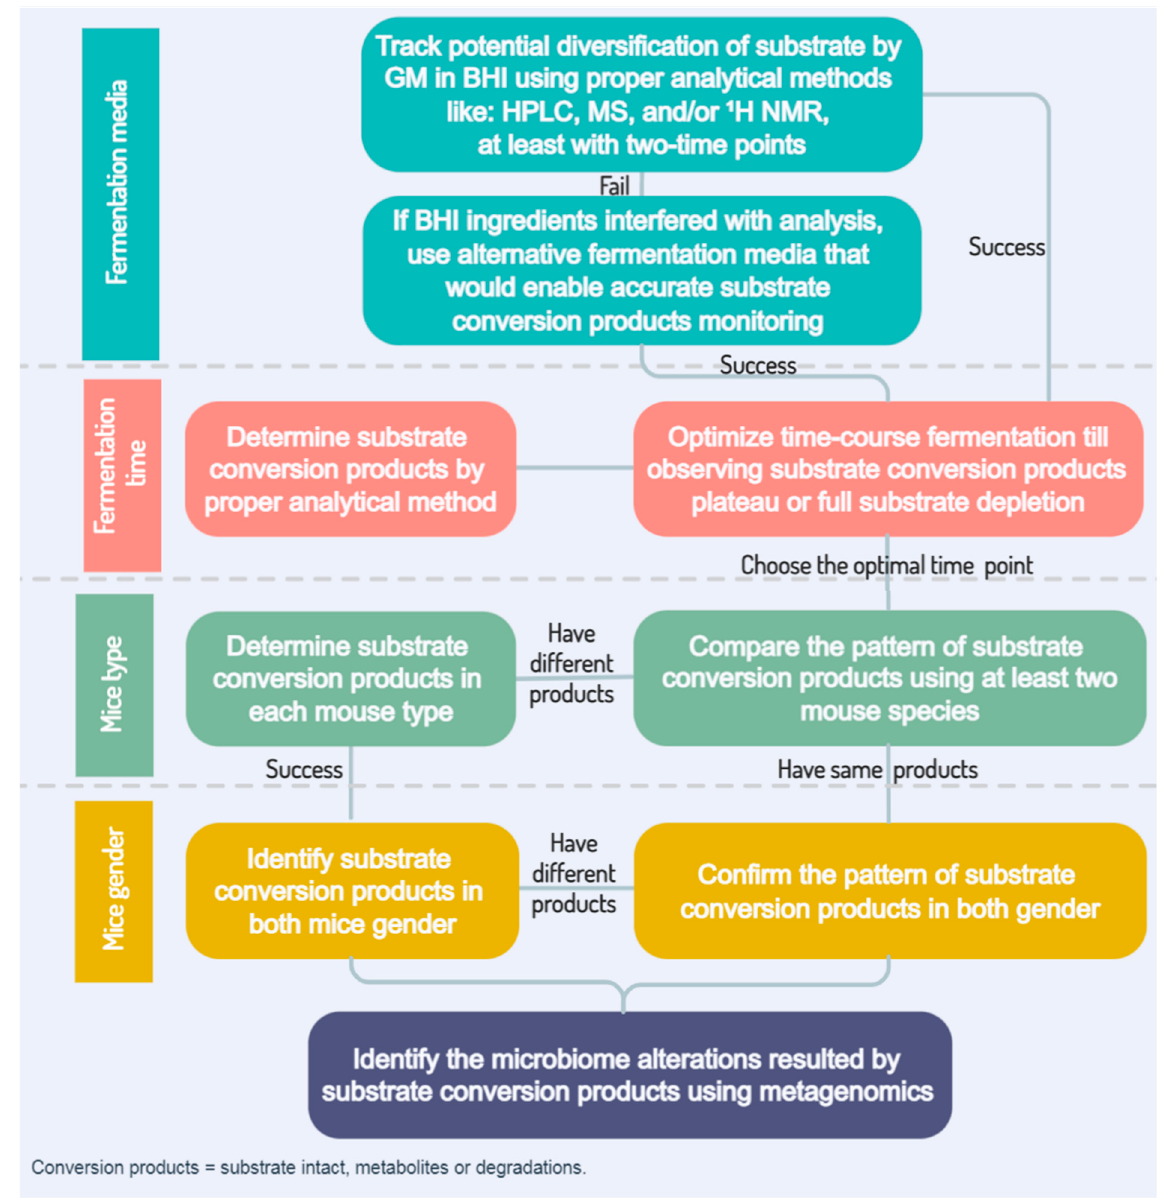
Figure 2. Overview flowchart of ex vivo GM-xenobiotic cross-interaction model.